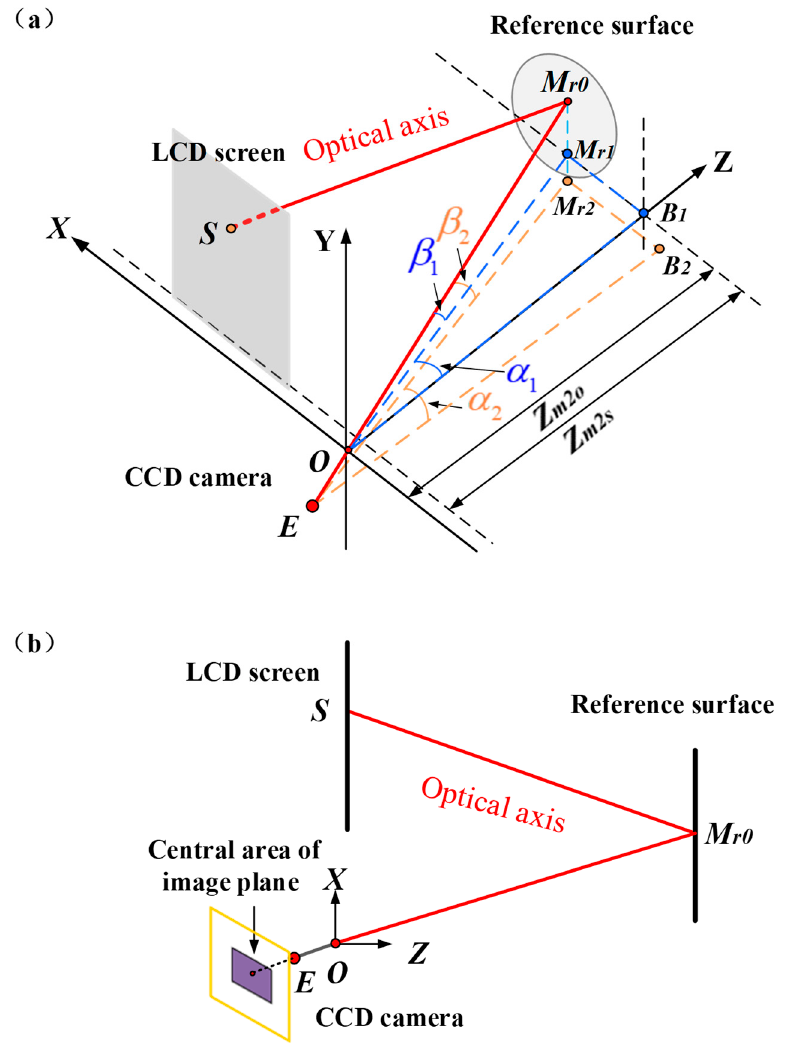
Figure 1. ( a ) Schematic diagram of the calibration of the entrance pupil center (point O is the external stop, point E is the entrance pupil center, and point M r 0 is a reflection point on the reference surface); ( b ) illustration of central area of the image.